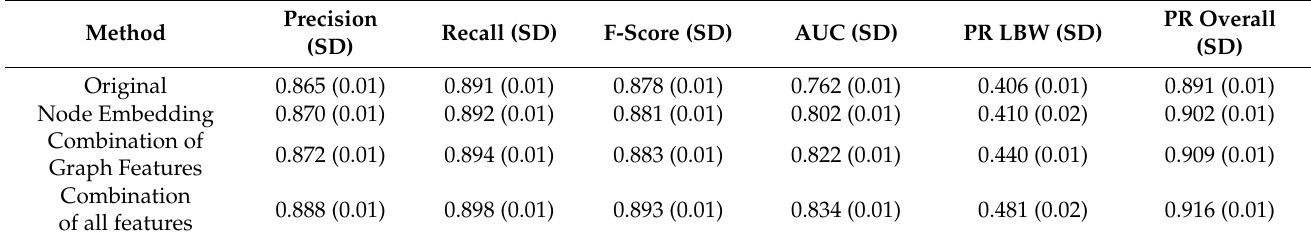
Table 9. Experimental results obtained using the XGBoost Classifier.